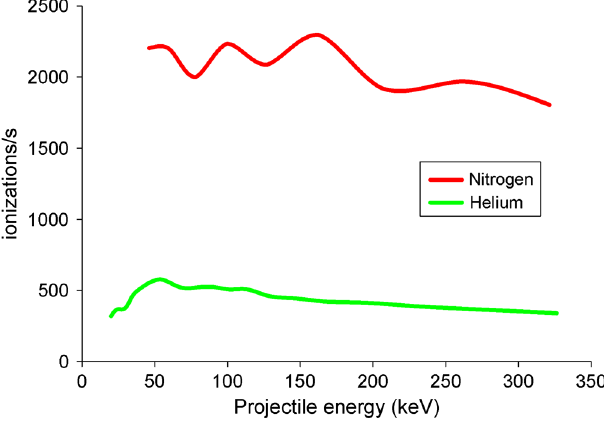
FIG. 7. Calculated reaction rates for antiprotons [38].